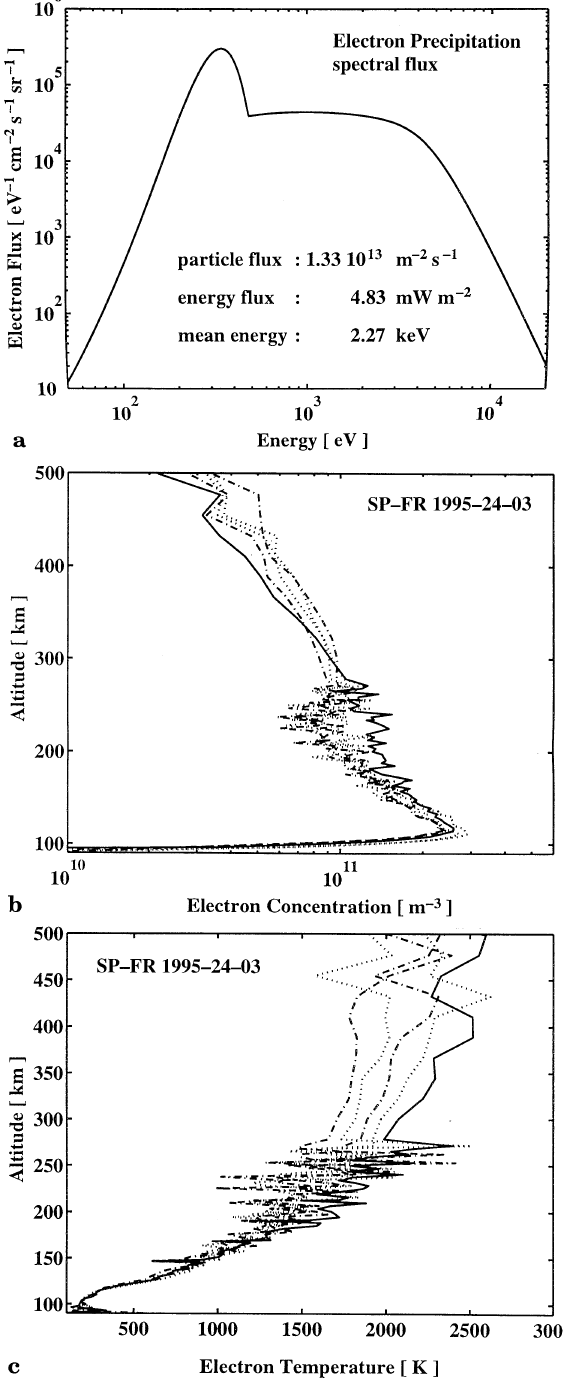
to adjust the model at 2300 UT. The low-energy part is a Maxwel- lian shaped function with a maximum reached at 350 eV. The high-energy part is a complex power-law function with a quasi- constant function between 500 eV and 4 keV and an asymptotic branch varying as the fifth power of the inverse of the energy above 4 keV; b the 5-min-integrated profiles of the electron concentration for the 20-min period centered on 2300 UT (the full line corres- ponds to 2300 UT, the dash - dotted lines to the period before and the dotted lines to the period after); c the same for the electron